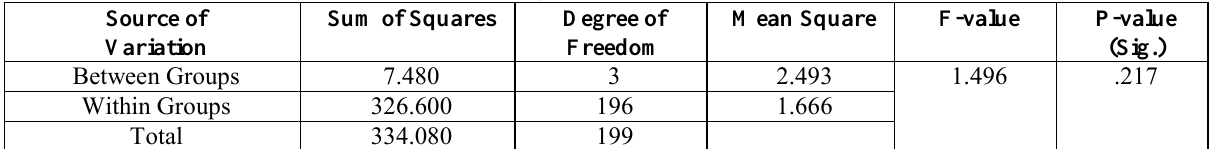
Analysis of Variance (ANOVA) results among North, East, West and South regions female baseball players with regard